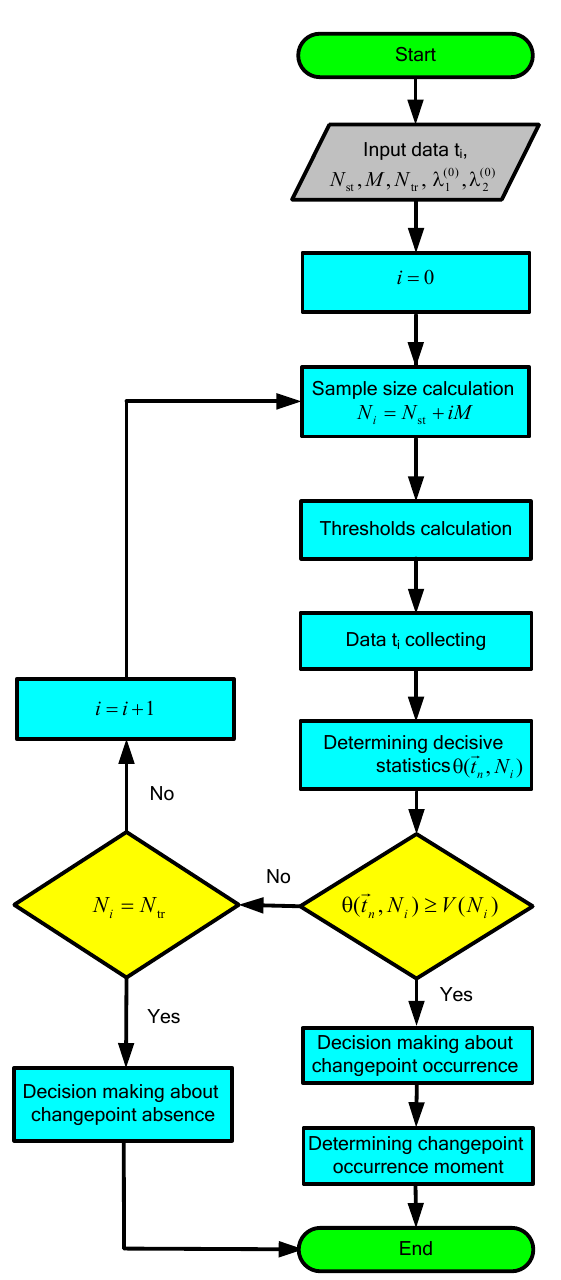
Fig. 2. The block diagram of algorithm.